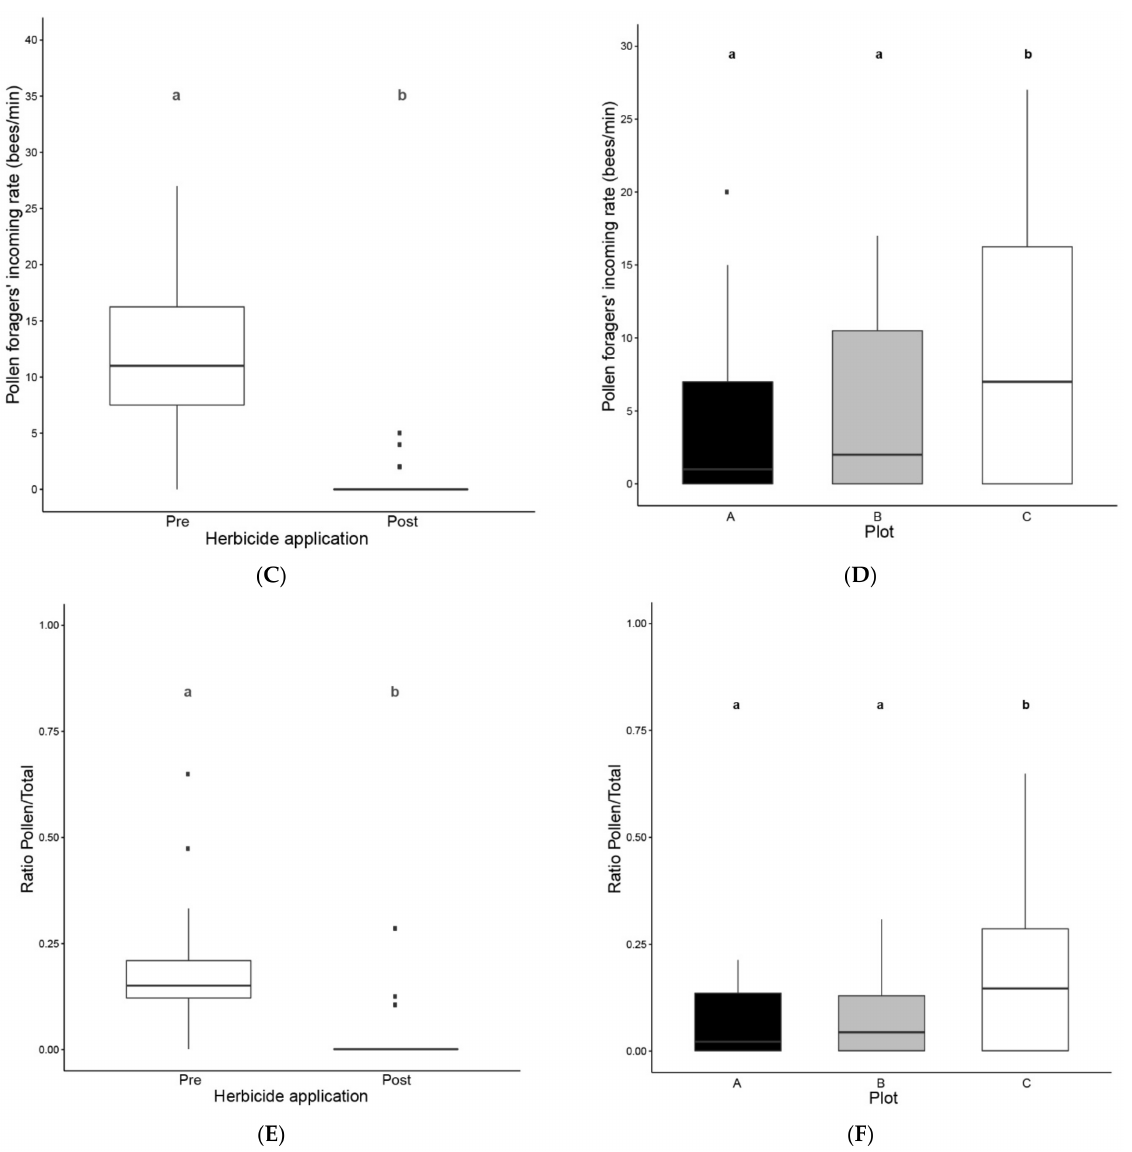
Figure 2. Colony activity. ( A , C , E ) Before and after post-emergence weed control ( B , D , F ) for each plot. ( A , B ) Number of bees entering the hive per minute, ( C , D ) number of bees entering the hive with pollen baskets per minute and ( E , F ) ratio of bees entering the hive with pollen baskets with regard to the total number of bees entering the hive. Boxplot shows the median and interquartile range (IQR), with whiskers showing the maximum value within 1.5 IQR, and individual points mark values outside this range. No significant differences (n.s.) were found between plots for the number of bees entering the hive per minute (N = 24, Friedman rank sum test). Different letters indicate significant differences between sampling moments ( p < 0.001, N = 24, Wilcoxon paired test). Different letters indicate significant differences between plots ( p < 0.001, N = 24, Friedman rank sum test). n.s., not